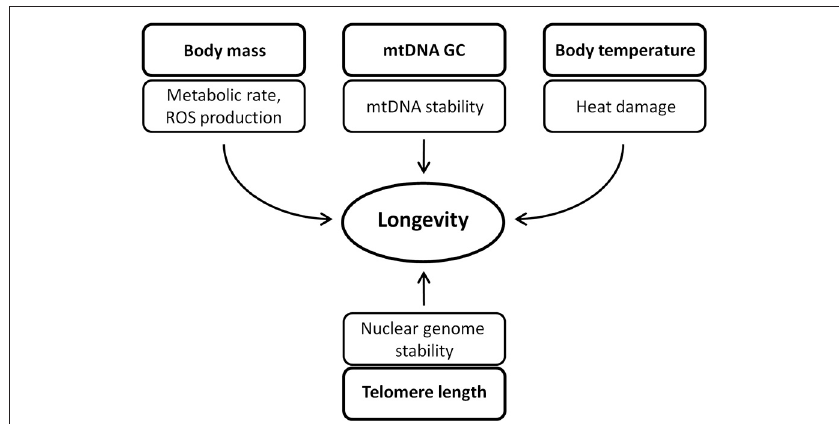
FIGURE 2 | Determinants of mammalian longevity. In the examined set of species, the relative contribution to MLS determination decreases in a descending order: Body mass > mtDNA GC content > Body temperature > Telomere length. Of note, 3 of 4 determinants (upper panel) are directly associated with mitochondria. For explanations, see the